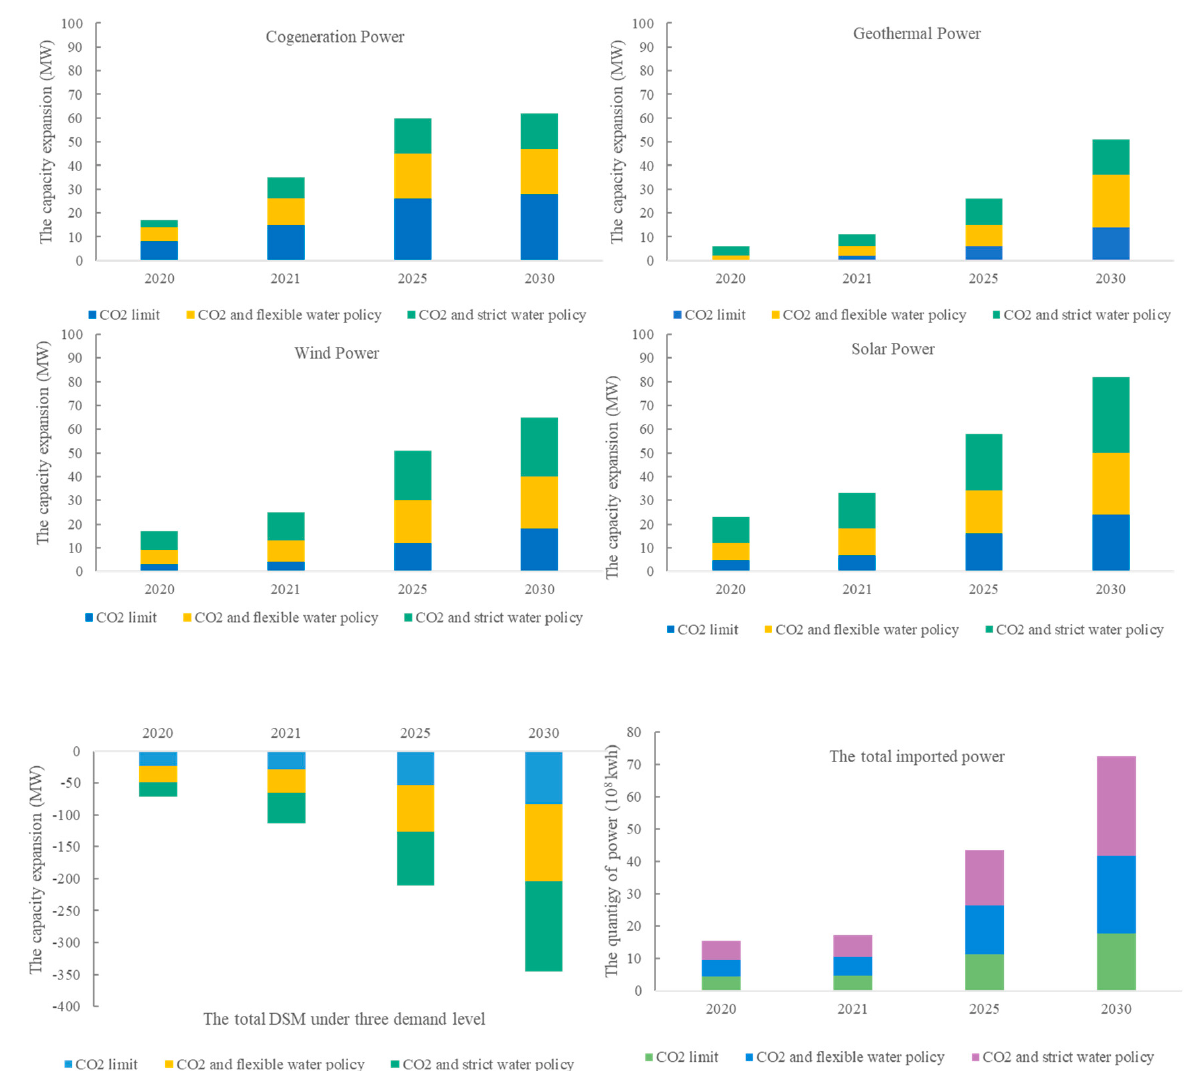
Figure 4. The capacity expansion level of different power resource, DSM, and the imported power.